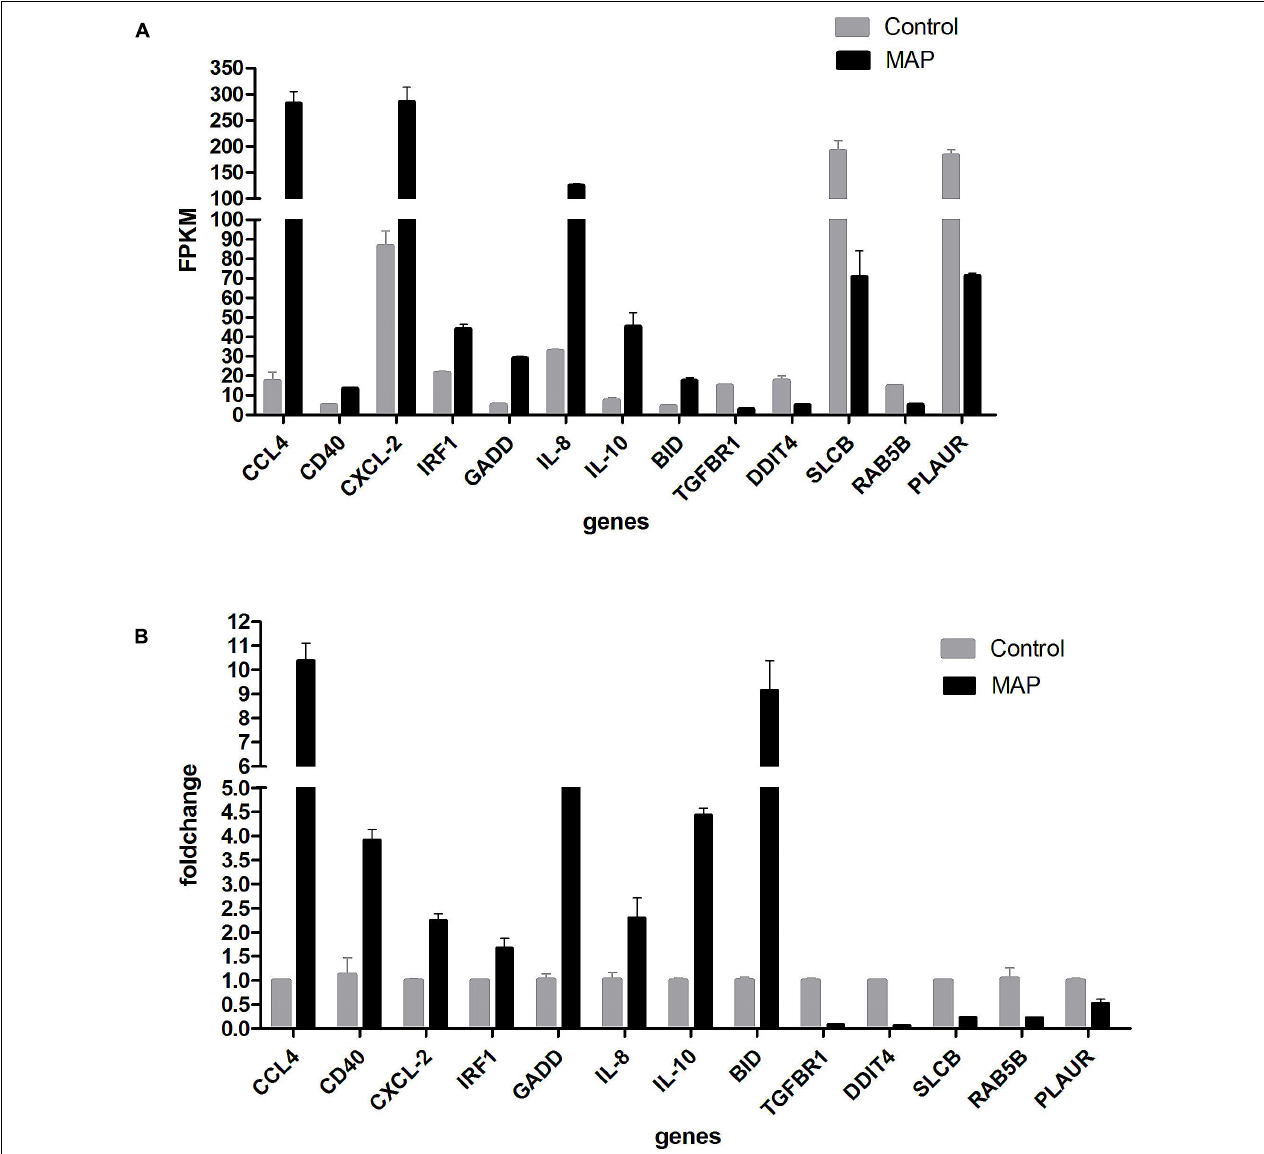
FIGURE 8 | (A) RT-qPCR validation. Expression of selected mRNAs validated with RT-qPCR. Drawing with genes as abscissa and FPKM as ordinates. (B) RT-qPCR validation. Expression of selected mRNAs validated with RT-qPCR. Drawing with genes as abscissa and fold-change as